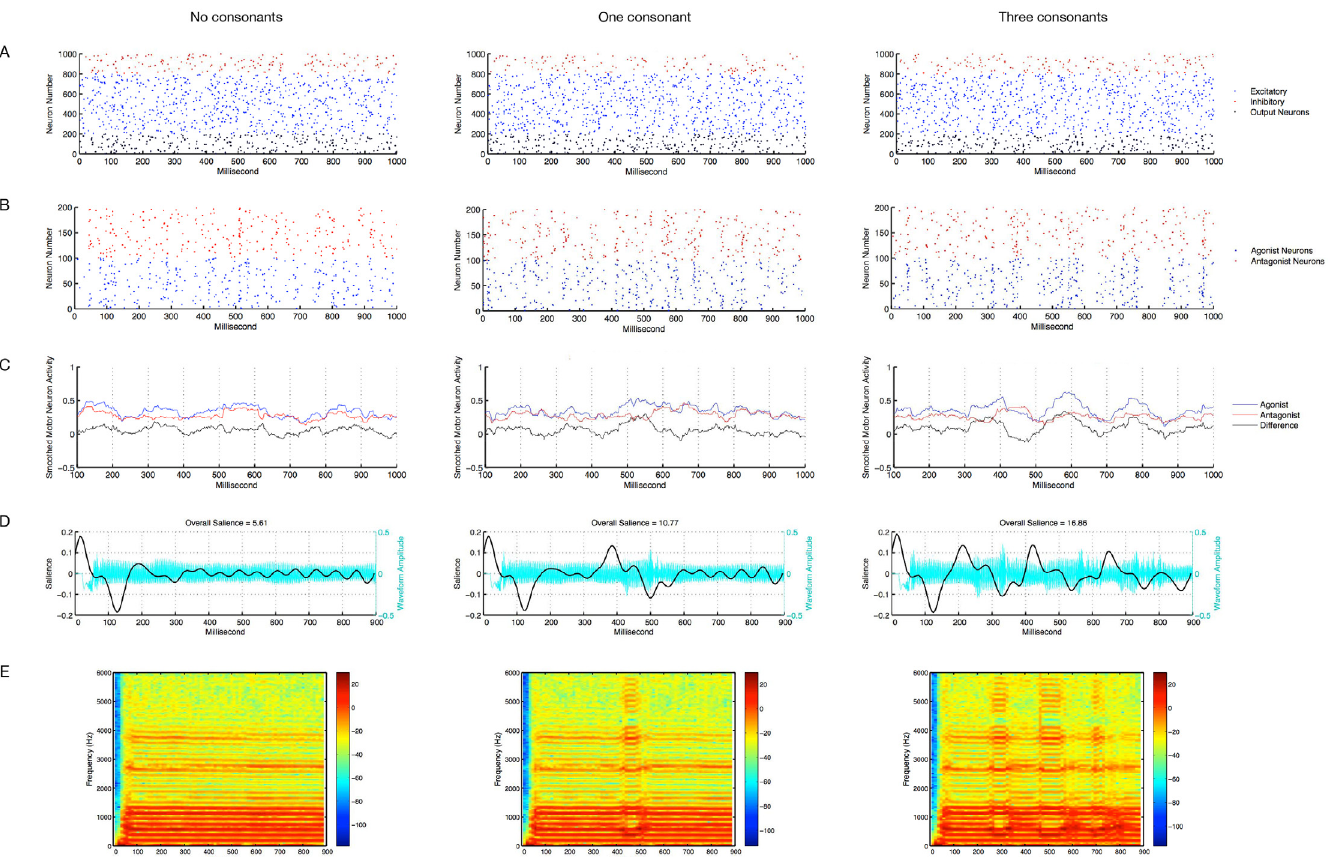
Fig 2. Vocalization examples. Three examples of vocalizations produced by the model. The left column shows a vocalization that contains no consonants and would not be considered canonical or syllabic babbling. The associated WAV file is available for listening in S1 Sound. The middle column shows a vocalization that contains one consonant and the right column shows a vocalization that contains three consonants. The middle and right vocalizations would qualify as canonical babbling (the associated WAV files are available for listening in S2 Sound and S3 Sound, respectively). The vocalizations were all produced by fully trained versions of the primary version of the model. A: Raster plots of the 1 s of reservoir neuron activity associated with the vocalization. B: motor neuron raster plots. C: Smoothed motor neuron activity for the agonist and antagonist groups as well as the difference between the smoothed agonist and antagonist activities. This difference was what was input as muscle activity to the vocalizations synthesizer. D: Waveforms (cyan), salience traces (black) and overall salience estimates (titles) for each example vocalization. Note that positive values of the salience trace represent detection of onsets of patterns in the auditory stimulus and negative values represent offsets of patterns. E: Spectrograms of the vocalizations; these provide visual evidence of the vocalization ’ s harmonic frequencies and of formant transitions associated with the production of